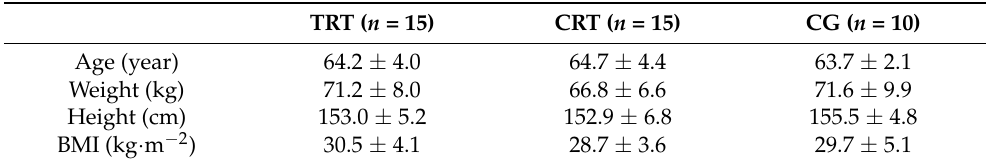
Table 1. Pre-training characteristics of the participants in each training group. Values are given as mean ± SD.